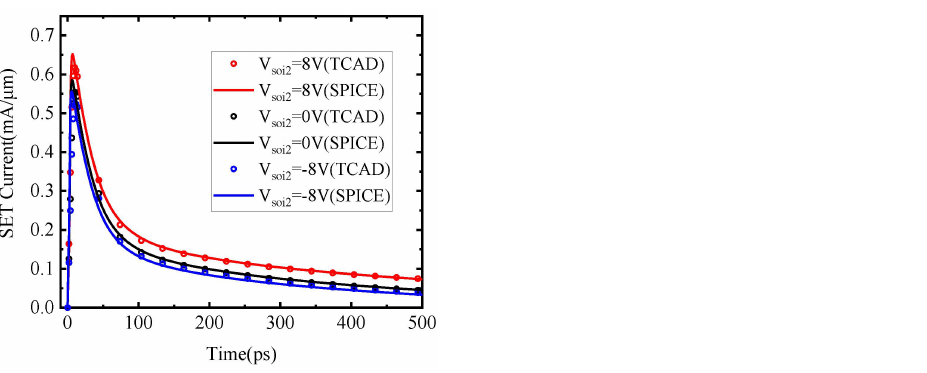
Figure 14. Total SET current with different back-gate voltages of TCAD simulation and SPICE